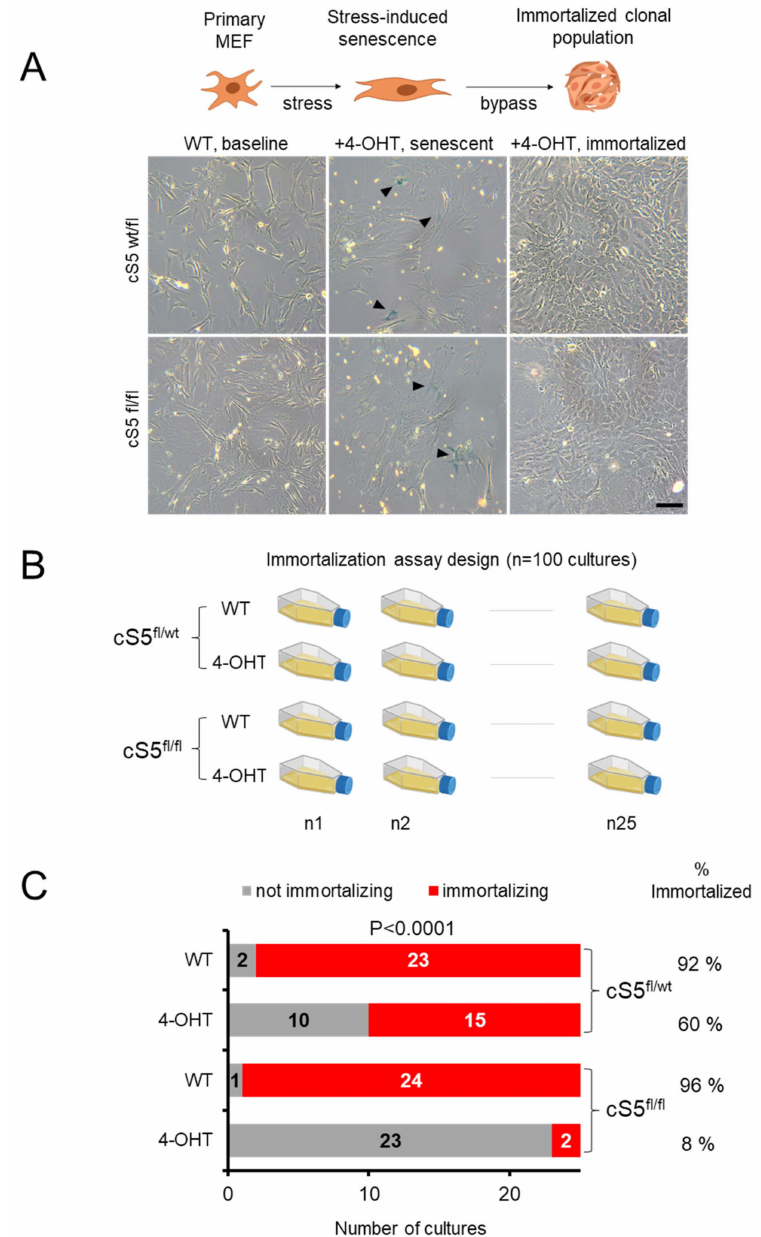
Figure 5. Large-scale analysis of the Smarca5 requirement for primary cell immortalization. ( A ) A schema showing senescence bypass and clonal immortalization in MEFs (top panel) and the representative cell culture images from the Smarca5 single and double allele knockout (bottom panel). Black arrowheads in the middle panels indicate the SA- β -gal staining of cells with typical senescent morphology. Scale bar = 50 µ m. ( B ) Immortalization setup for Smarca5 knockout MEFs, twenty-five flasks for each condition were cultured over periods of several weeks until they bypassed senescence or died, to check the ability of the MEFs to overcome senescence and immortalize; created with BioRender.com. ( C ) Bar graphs show the total number of cultures out of twenty-five starting cultures that managed to immortalize when cells were grown for prolonged periods of time. NOTE: the P -value in ( C ) reflects the significance of difference between the conditions and it was calculated based on X 2 test with the degree of freedom equal to